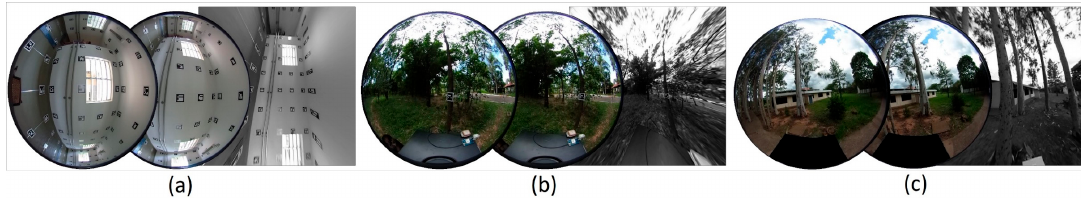
Figure 7. Sample of omnidirectional and rectified images from the test areas: ( a ) data set I—indoor, ( b ) data set II—forest, and ( c ) data set III—urban scenes.